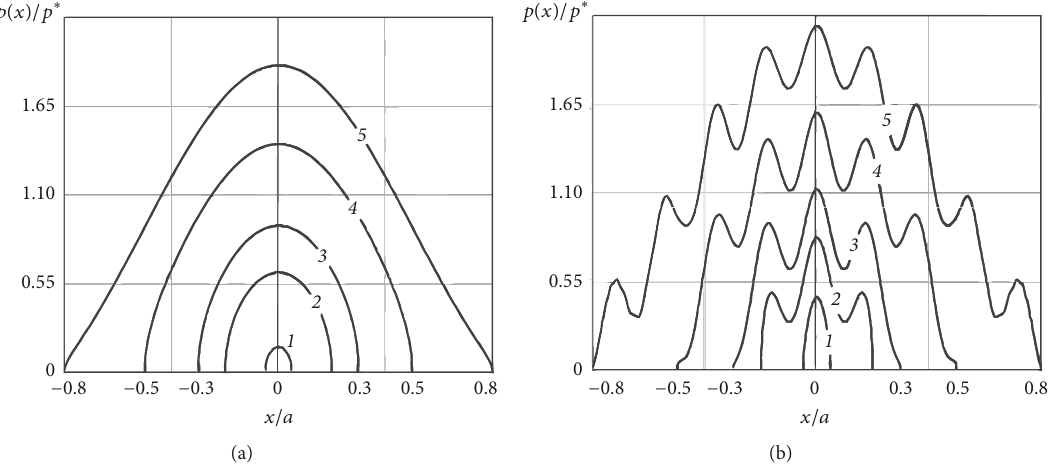
Figure 2: Evolution of contact pressure distribution for wavy periodic profile ( 𝜆 1 = 2 𝜋 , Δ 1 = 0.5): f ( x ) = Δ 1 cos (𝑥) (a); f ( x ) = (𝑥) +0.02 Δ (11𝑥) (b); 2 a = 0.05 𝜆 Δ 1 cos 1 cos